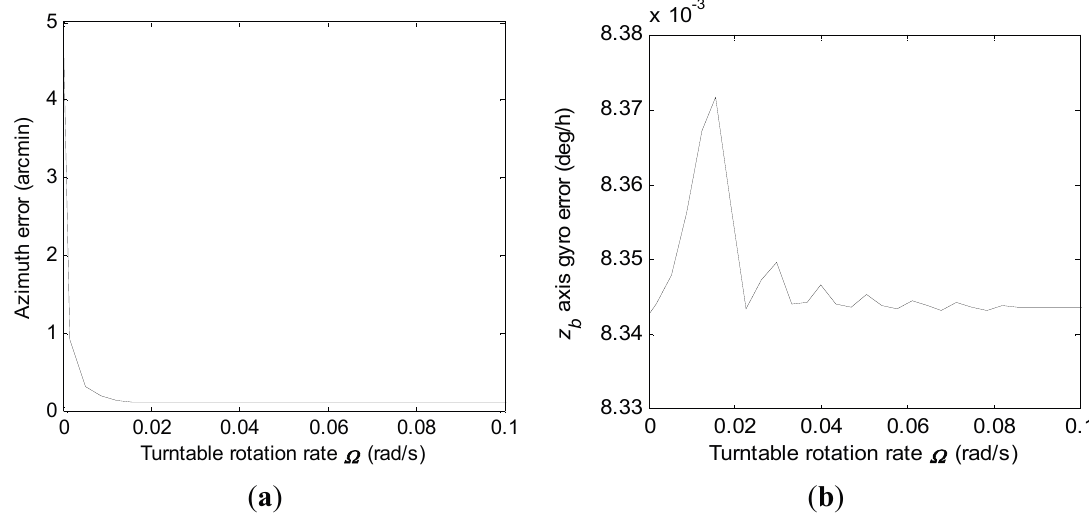
Figure 7. 1- σ values of final azimuth error and final z b axis gyro error at 600 s computed according to turntable rotation rates ranging from 0.0003 rad/s to 0.1 rad/s when using the constrained KF scheme and r g is 0.2 deg/h. ( a ) Azimuth error; ( b ) z b axis gyro erro. 3.2.3. Convergence Rates of the Azimuth Error and the z b Axis Gyro Error By setting r 0 and Ω to be 0.01 m/s and 0.6981 rad/s respectively, the convergence rates of the